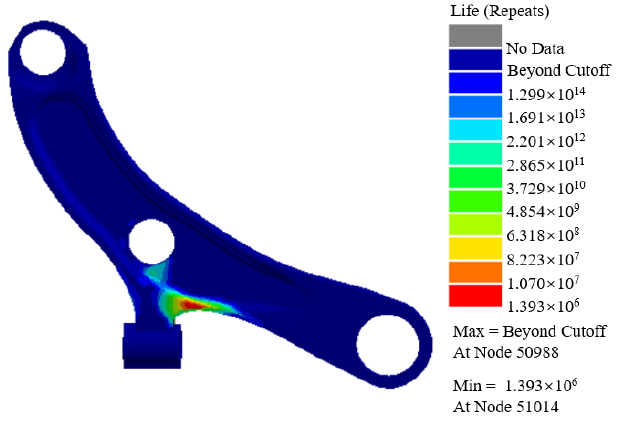
Figure 9. Fatigue life contour of control arm.